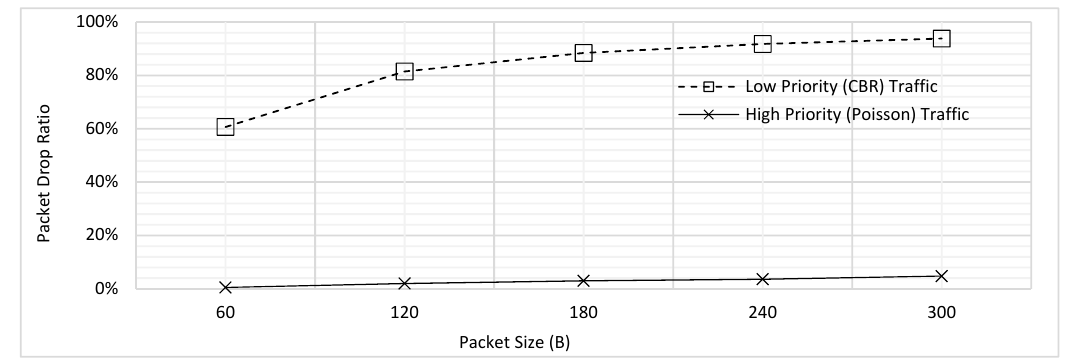
Figure 11. PDR for Prioritization using Fragmentation (Fragment Size = 1B).